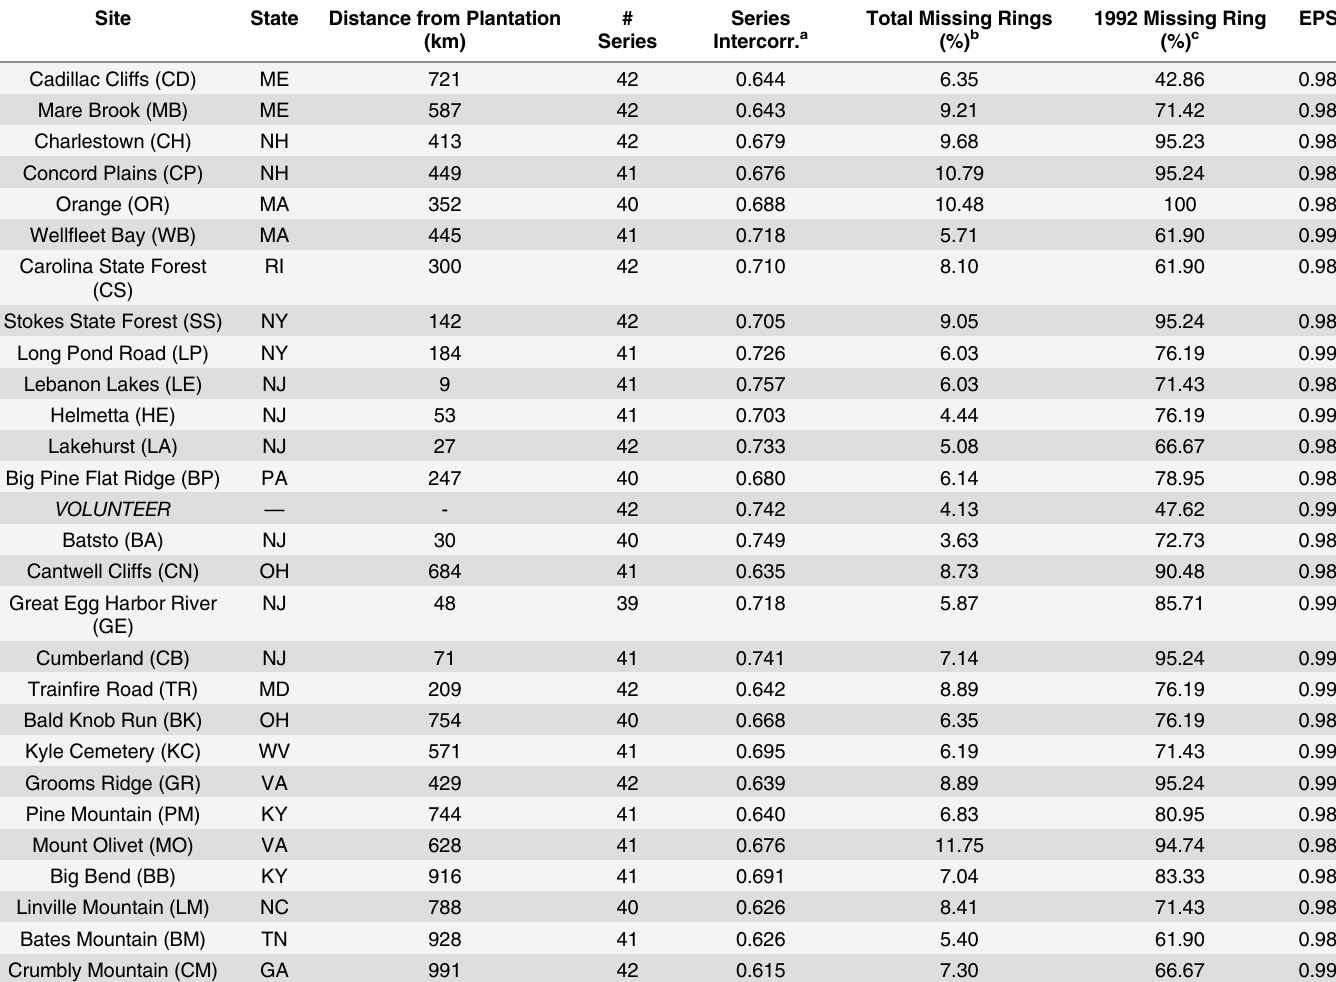
Table 1. List of seed sources and relevant